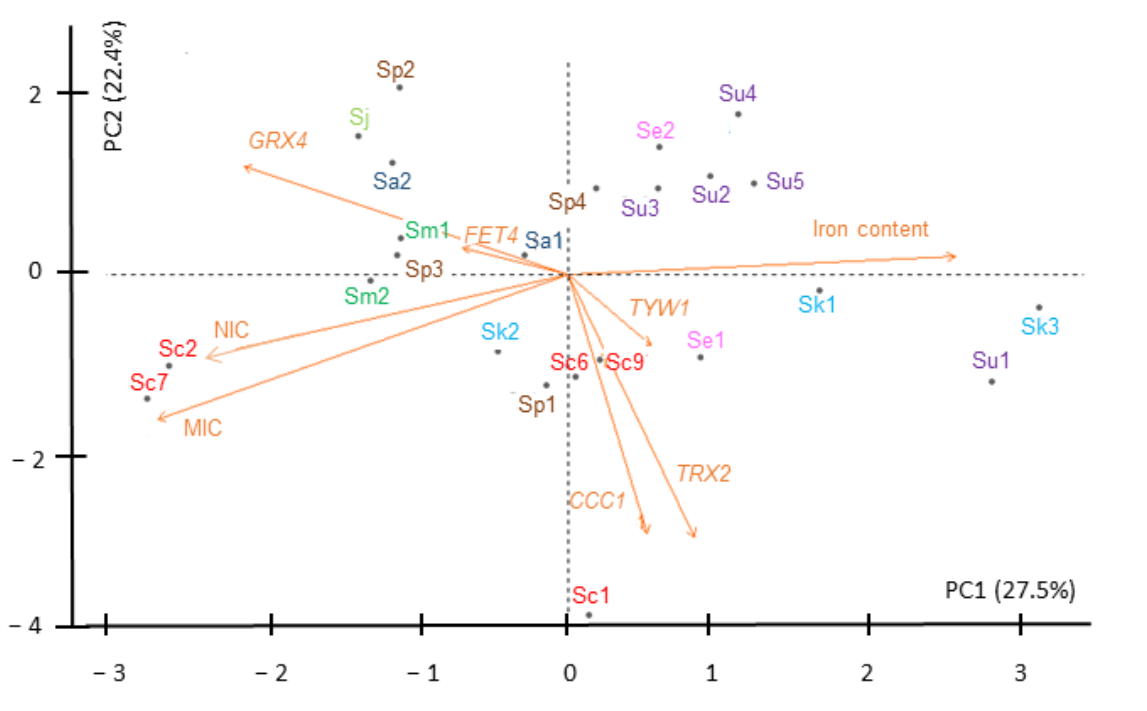
Figure 9. Behavior of Saccharomyces strains according to iron sensitivity, iron accumulation and gene expression. Two-dimensional principal component analysis (PCA) biplot of NIC, MIC, iron accumulation and gene expression of Saccharomyces strains under high-iron exposure. Contribution of each variable to the variance is represented by the arrow length of the vectors. Strains (individuals) are depicted by the color code and abbreviations used in previous figures.